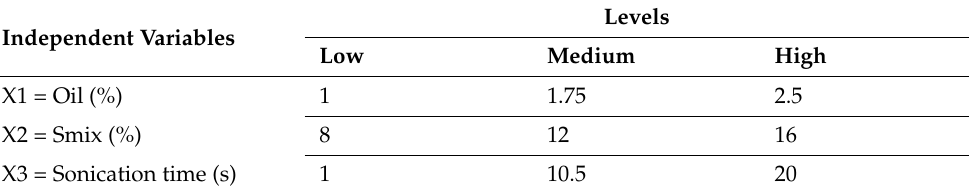
Table 3. Selected independent variables and their levels.